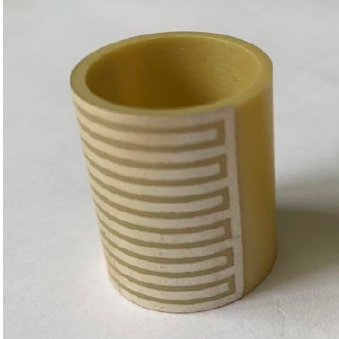
Figure 6. The samples of the piezoceramic tube actuator with interdigitated electrodes (180-de- gree).